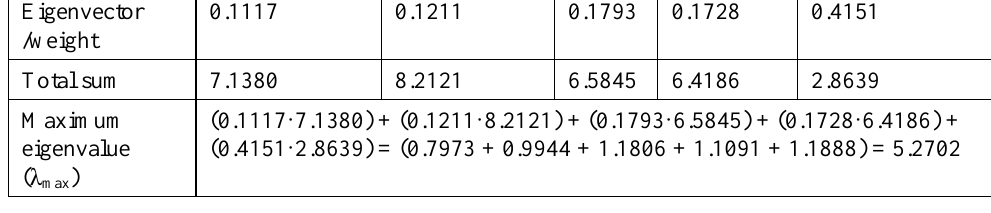
Table 2. Calculation of the Maximum Eigenvalue of the Five Criteria with Respect to Goal which States the Determinant of Entrepreneurial Orientation Criteria Innovativeness Proactiveness Risk Autonomy Competitiveness Taking